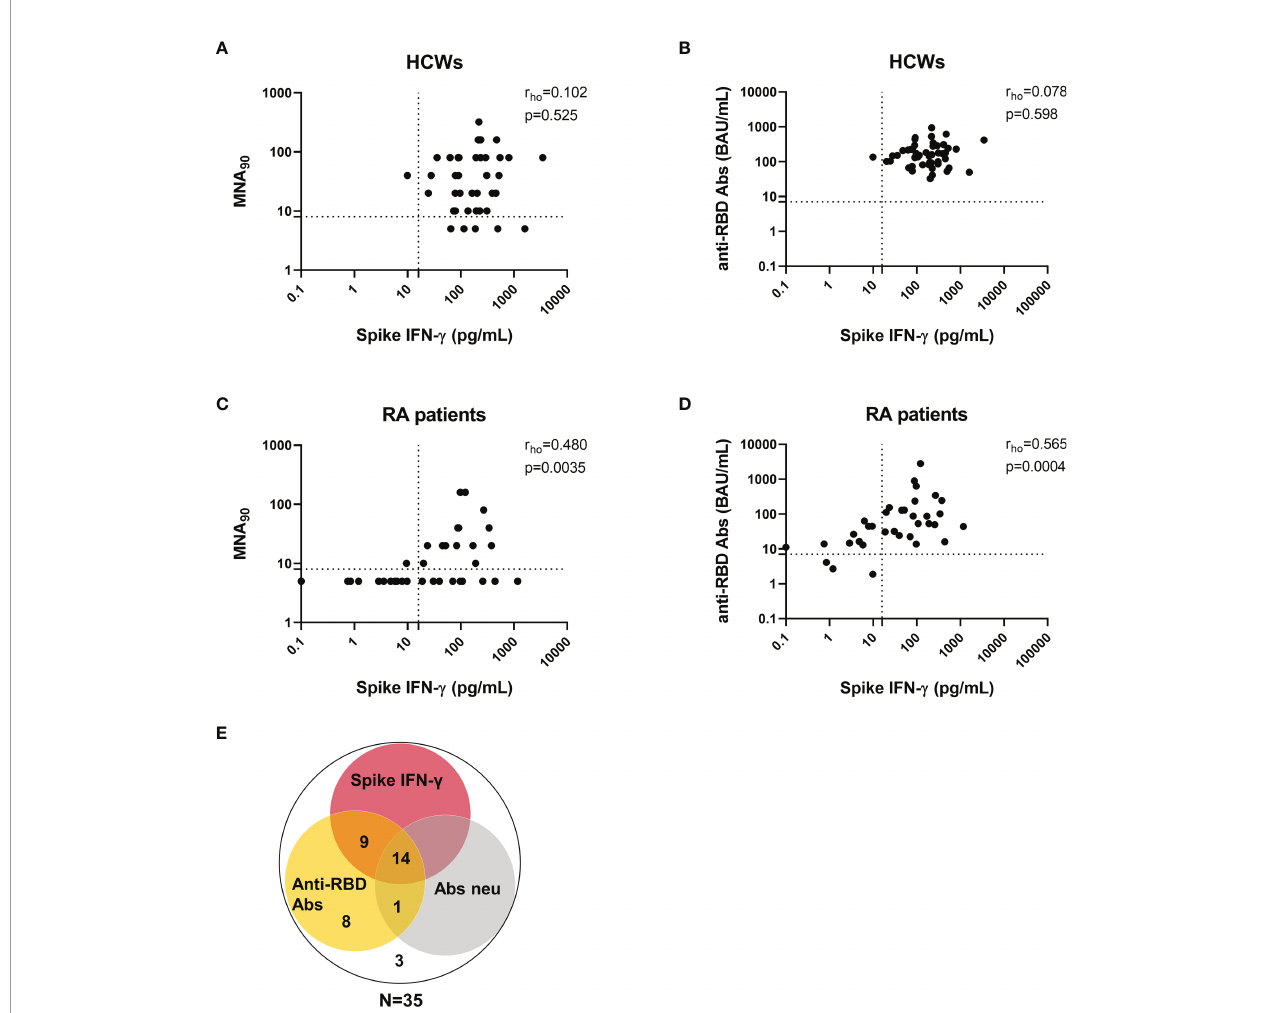
FIGURE 7 | Correlation between T-cell response and anti-RBD or neutralizing antibodies in HCWs and RA patients. Correlation between neutralizing antibodies and the IFN- g -spike-speci fi c T-cell response in HCWs (A) and RA subjects (C) . Correlation between anti-RBD antibodies and the IFN- g -spike-speci fi c T-cell response in HCWs (B) and RA subjects (D) . Anti-RBD and neutralizing antibodies were quanti fi ed in serum samples and expressed as binding antibody units (BAU)/ml and reciprocal of dilution (MNA 90 ), respectively. T-cell response to spike antigen was assessed by measuring IFN- g levels and reported after subtracting the background. Dashed lines identify the cutoff of each test (anti-RBD: 7.1 BAU/ml; MNA 90 : 8 and spike: 16 pg/ml). Correlation between assays was assessed by non-parametric Spearman ’ s rank test (p < 0.05). (E) Venn diagram shows positive results with anti-RBD IgG, neutralizing antibodies and IFN- g T-cell response. RA, rheumatoid arthritis; RBD, receptor-binding domain; HCWs, health care